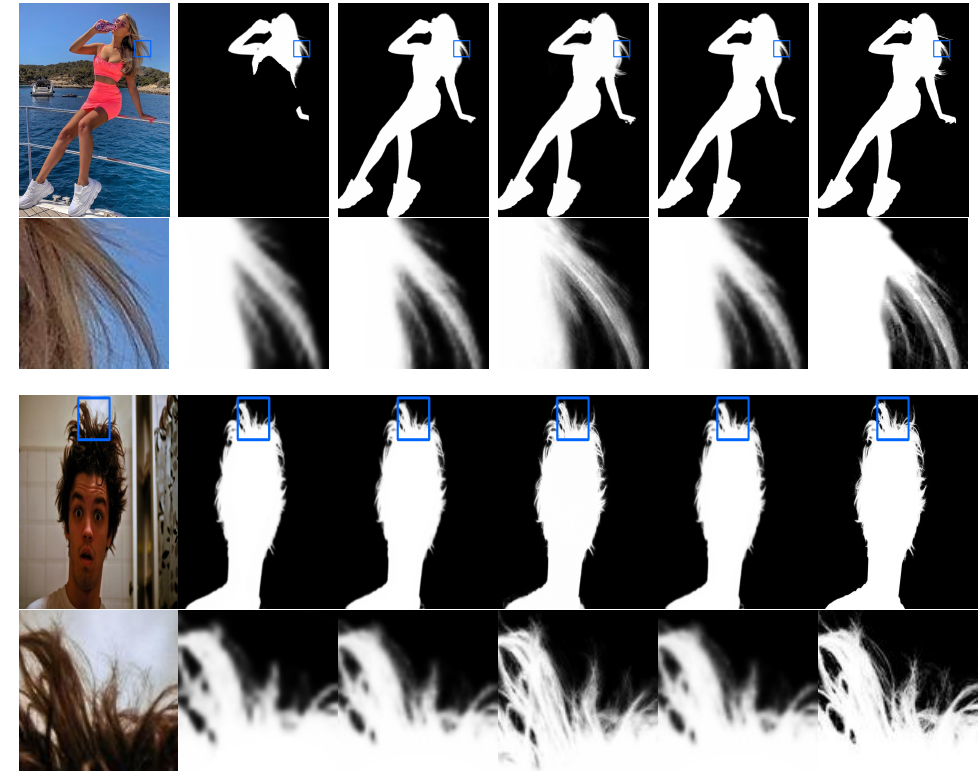
Figure 5. Visual comparisons for portrait matting. From left to right, the above figures show the original images, the results of GFM [59] architecture, the results of P3M [58] architecture, the results of MGM [61], and the results of ViTAE [62] and the results of our